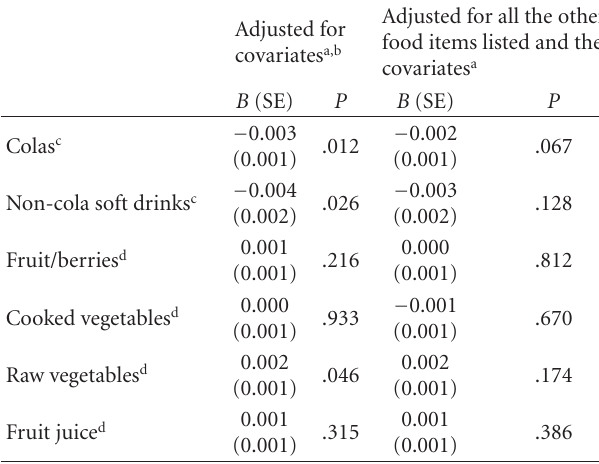
Table 2: Association between single items of foods/beverages possi- bly influencing the acid load and distal forearm bone mineral den- sity, adjusted for possible confounding variables. Linear regression.